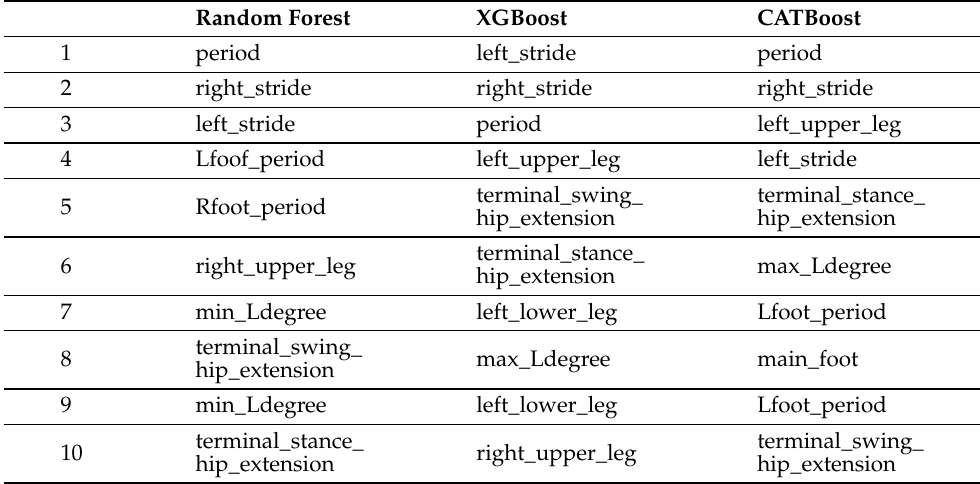
Table 2. The top 10 important features identified by the ensemble approaches. Random Forest XGBoost